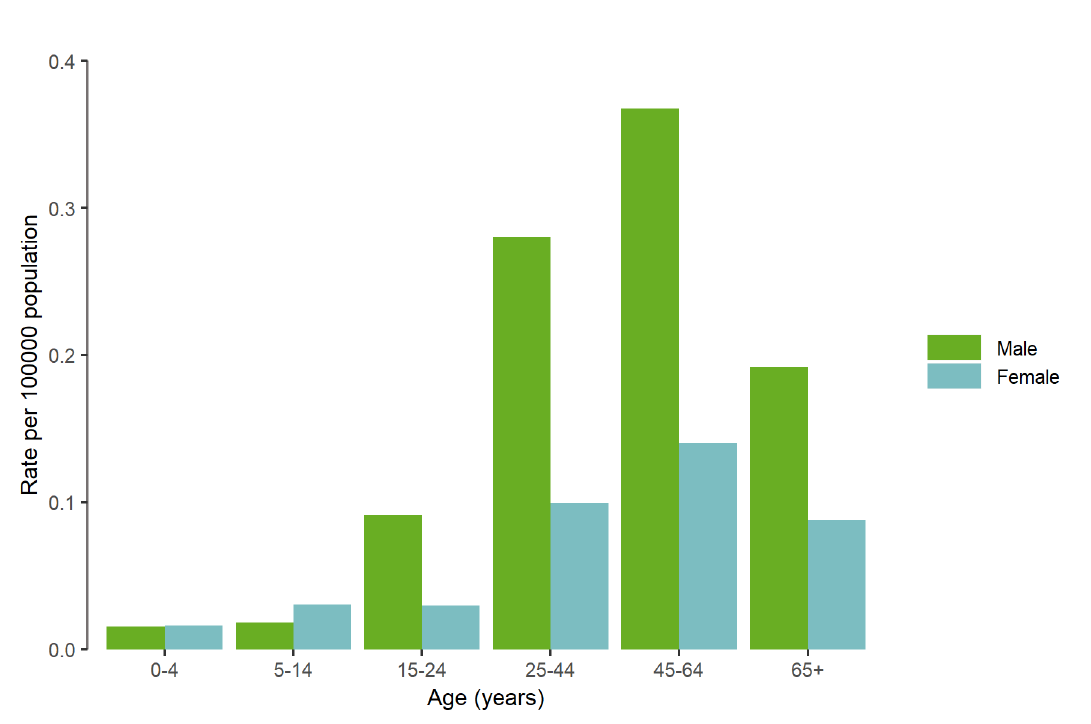
Figure 4. Distribution of confirmed Q fever cases per 100 000 population, by age and gender, EU/EEA,